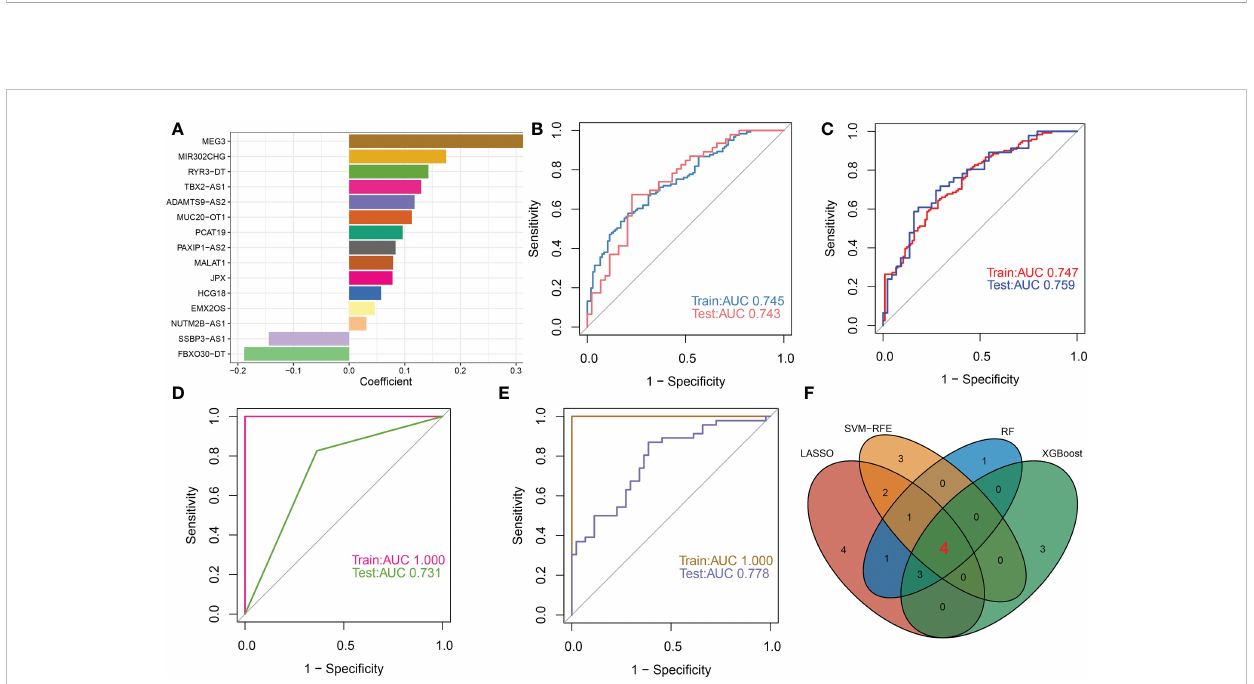
FIGURE 9 Selection of characteristic lncRNAs associated with DDR based on multiple machine learning models. (A) The speci fi c coef fi cient value of the 15 DDR-associated lncRNAs screened by the optimal lambda value using the LASSO algorithm. (B) The value of ROC curves for the 15-lncRNA-based LASSO algorithm in the training set and testing sets. (C) The value of ROC curves for the 9-lncRNA-based SVM-RFE algorithm in the training set and testing sets. (D) The value of ROC curves for the 14-lncRNA-based RF algorithm in the training set and testing sets. (E) The value of ROC curves for the XGBoost algorithm in the training set and testing sets. (F) Venn diagram displaying the intersection results of the LASSO, SVM-RFE, RF and XGBoost